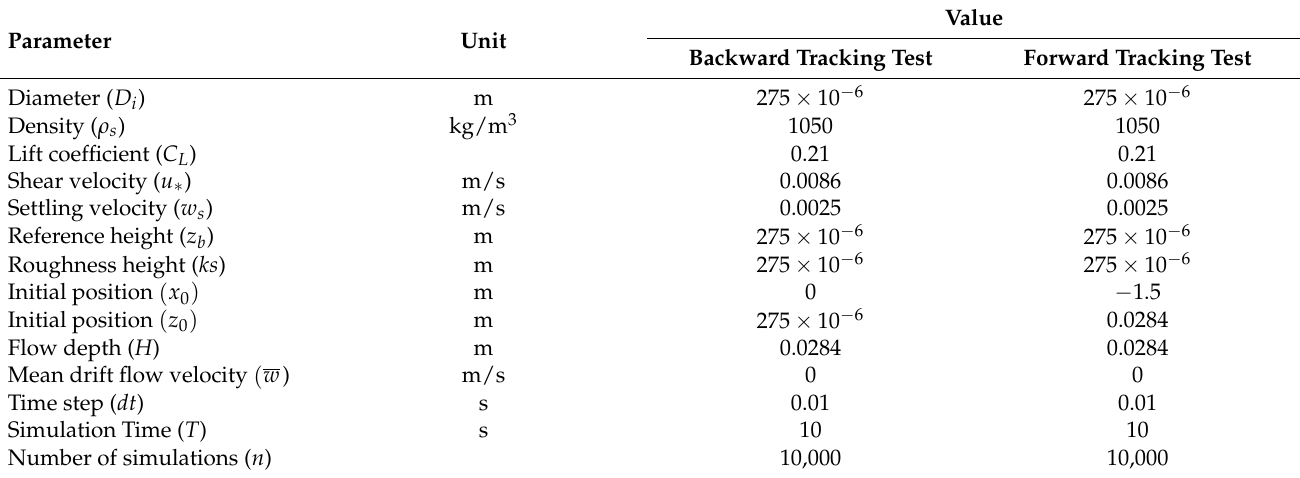
Table 1. Particles, initial conditions, flow conditions, and simulation parameters for backward and forward tracking